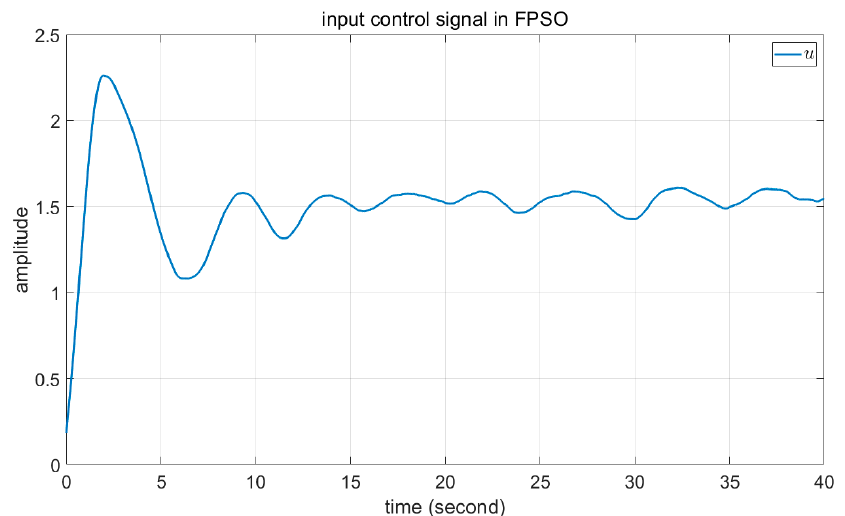
Figure 13. The input control signal of state feedback in FPSO.